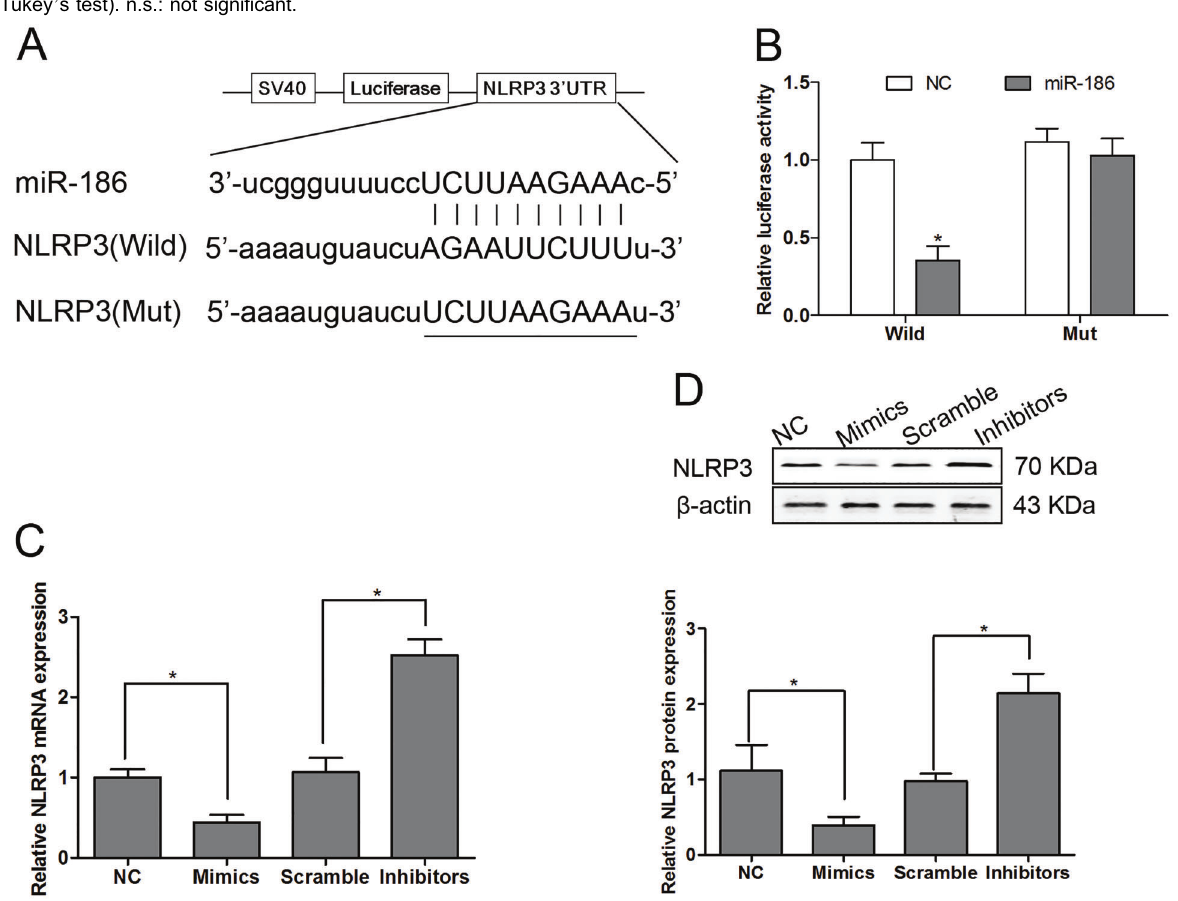
Figure 6. Schematic representation of the putative miR-186 binding site in the 3 0 UTR of NLRP3 predicted by the miRanda Target database ( A ). The ND8/34 cells were co-transfected with the wild and mutant (Mut) of NLRP3-3 0 -UTR and miR-186 mimics, inhibitors, or scramble, and the luciferase activity assay was performed after 48 h transfection ( B ). The ND8/34 cells were transfected with miR-186 mimics, inhibitors or scramble, and the mRNA ( C ) and protein ( D ) expressions of NLRP3 were measured by RT-qPCR and western blotting, respectively (n=6 at each time-point). Data are reported as means ± SD. *P o 0.05 vs control group (NC) (ANOVA followed by a post hoc Tukey ’ s